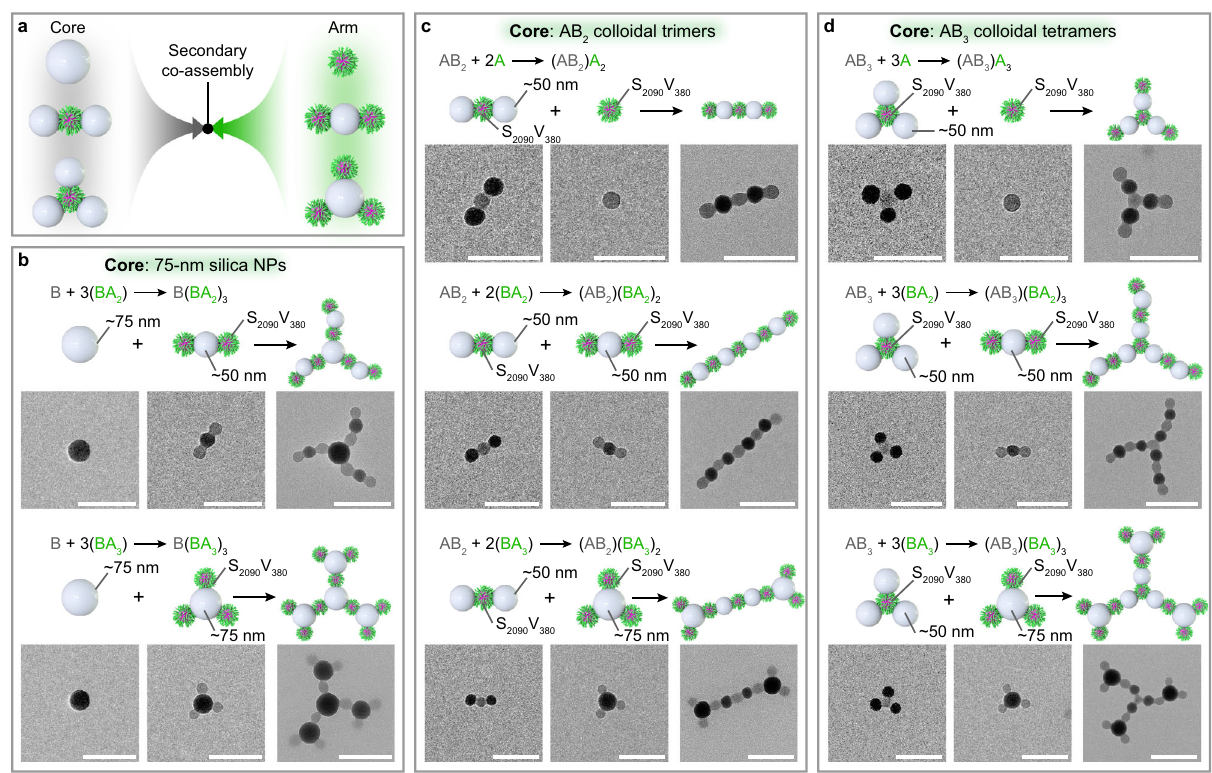
Fig. 3 Secondary co-assembly of SV micelles and silica NPs. Hierarchical assembly of primary colloidal molecules favors the construction of core-arm- structured colloidal conjugates. a Schematic illustration of secondary co-assembly of core and arm species to generate core-arm-structured colloidal conjugates. b Co-assembly of 75-nm silica NPs with S 2090 V 380 -micelles-capped BA 2 (B = 50-nm silica NP) trimers and BA 3 (B = 75-nm silica NP) tetramers into branched colloidal conjugates. c Co-assembly of silica-NPs-capped AB 2 (A = S 2090 V 380 micelle, B = 50-nm silica NP) trimers with S 2090 V 380 micelles, S 2090 V 380 -micelles-capped BA 2 (B = 50-nm silica NP) trimers, and S 2090 V 380 -micelles-capped BA 3 (B = 75-nm silica NP) tetramers into linear colloidal conjugates. d Co-assembly of silica-NPs-capped AB 3 (A = S 2090 V 380 micelle, B = 50-nm silica NP) tetramers with S 2090 V 380 micelles, S 2090 V 380 -micelles-capped BA 2 (B = 50-nm silica NP) trimers, and S 2090 V 380 -micelles-capped BA 3 (B = 75-nm silica NP) tetramers into branched colloidal conjugates. Scale bars = 200 (AB 3 )(BA 3 ) 3 colloidal conjugates (Fig. 3d and Supplementary Figs. 34 – 36).